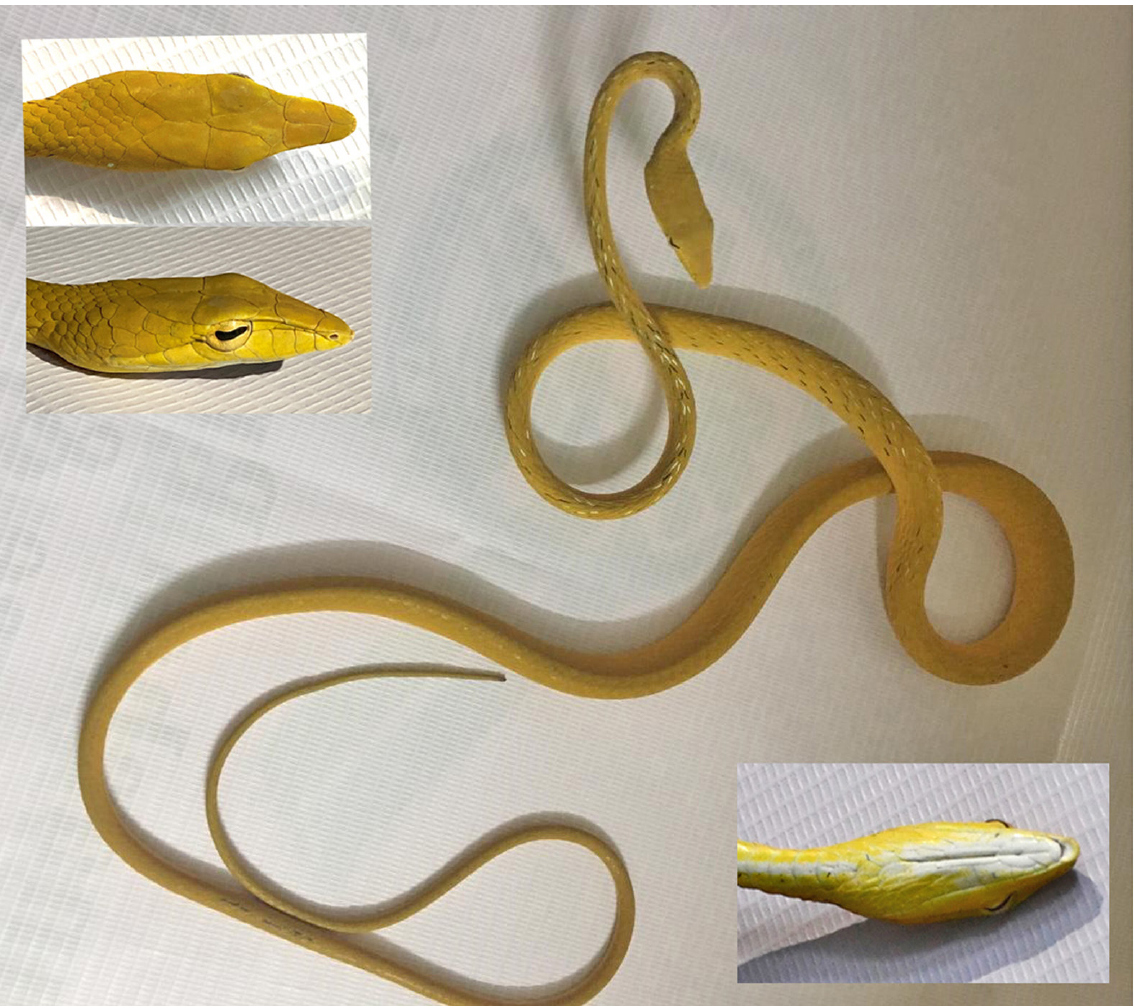
Fig. 7. Ahaetulla flavescens (Wall, 1910) comb. nov. Live uncollected specimens from Arunachal Pradesh, showing the unusual buff or yellowish-brown colouration. Photo: Bharat Bhushan